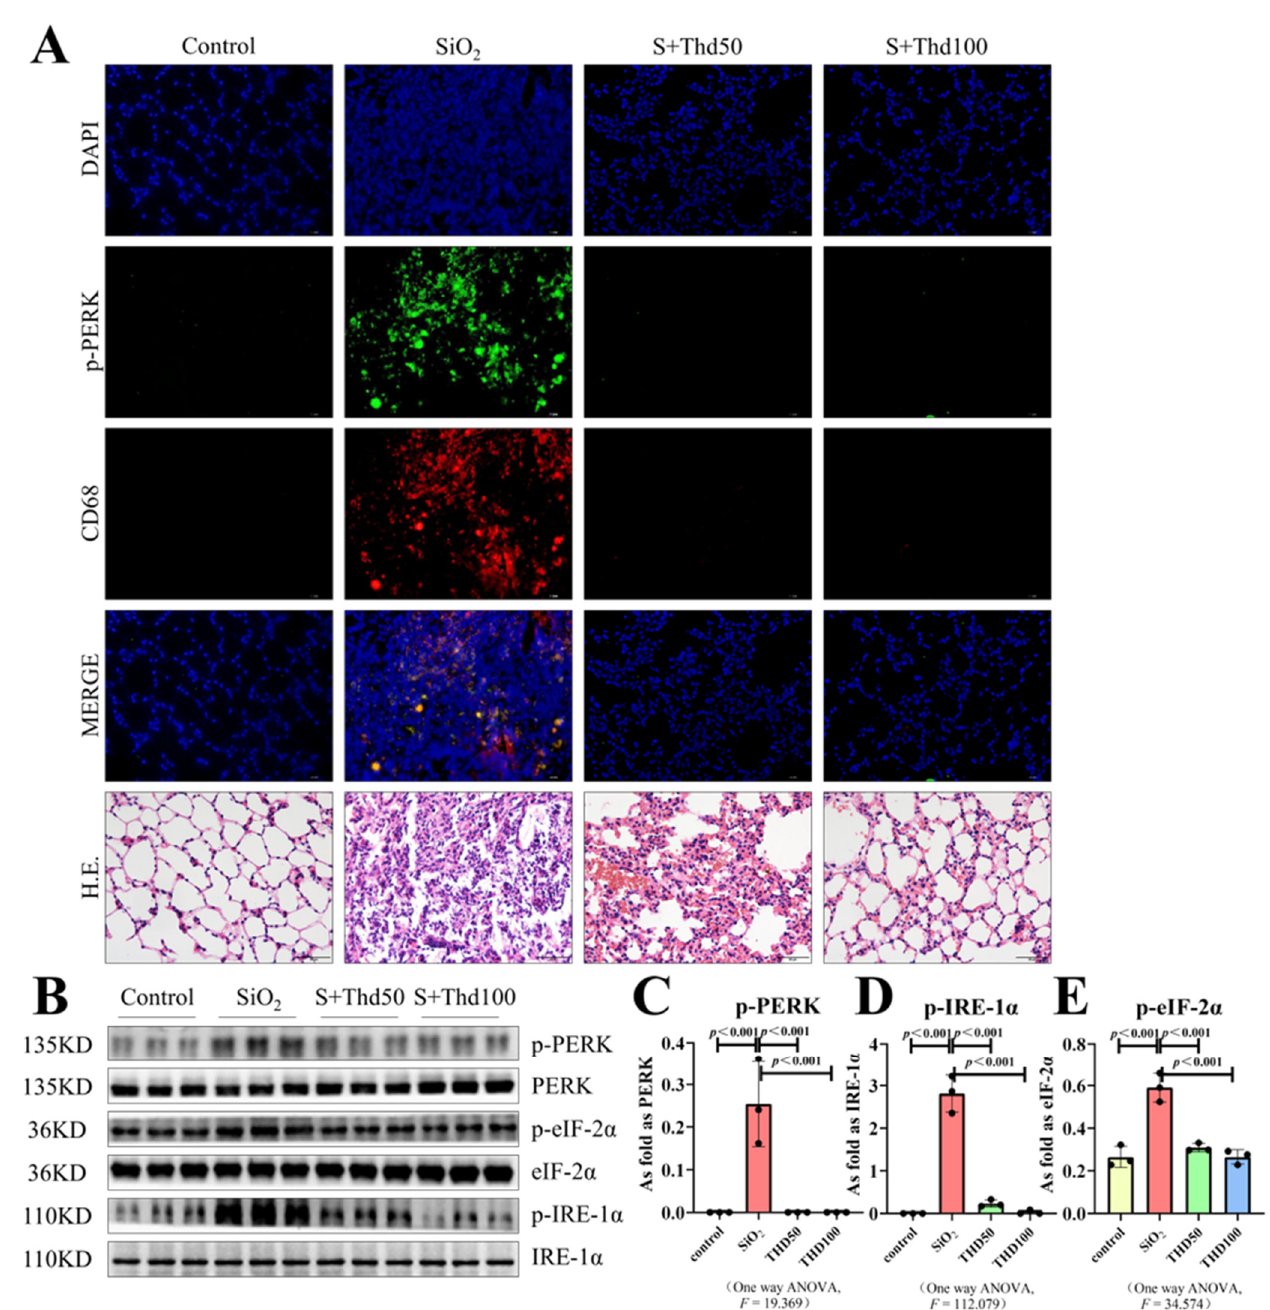
Figure 3. Thalidomide inhibited the ER stress signal in silicosis mice. ( A ) Expression of p-PERK in silicosis mice measured by IF staining (scale bar = 50 µm). ( B – E ) Expression levels of p-PERK, p-eIF-2 α , and p-IRE-1 α in the lungs of mice measured by Western blot. Data are presented as the mean ± SD, n = 3 per group.